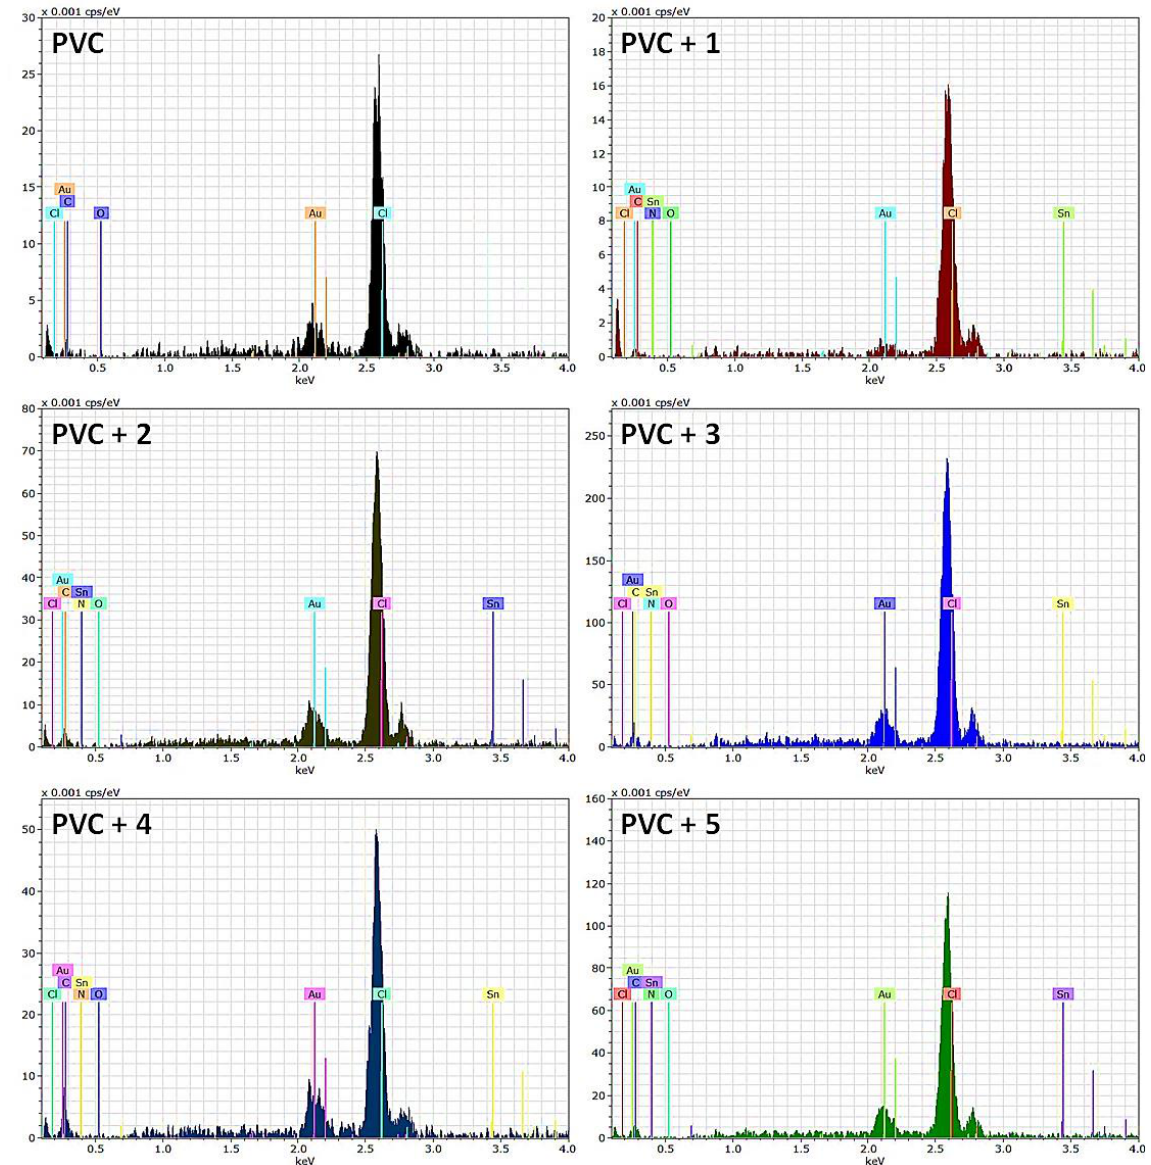
Figure 1. EDX spectra of PVC